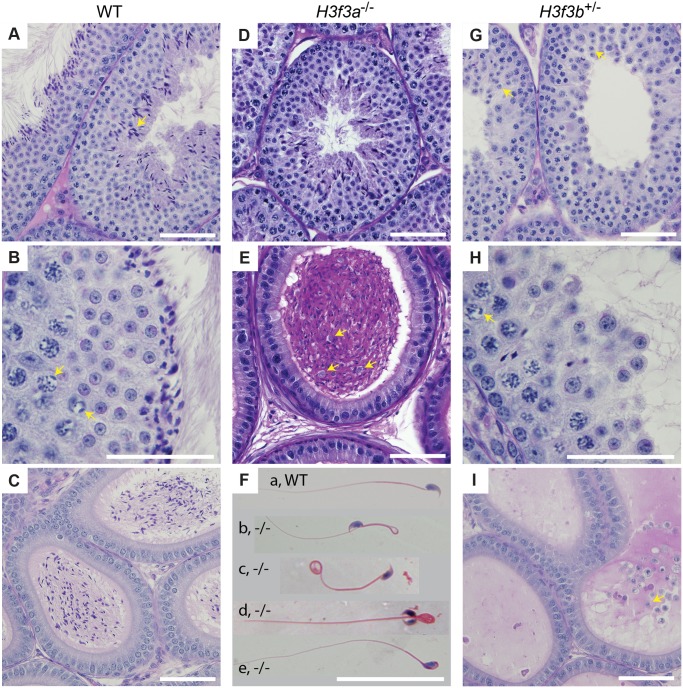
Testis and sperm morphology.WT adult, 6–10 months: (A) seminiferous tubule, condensing spermatid indicated (arrow), (B) seminiferous tubule, XY-body indicated (arrows), (C) cauda epididymis. H3f3a
-/- adult, 6–10 months: (D) seminiferous tubule, (E) cauda epididymis, sloughed germ cells indicated (arrows), (F) spermatozoa, genotype as given; (a) normal, (b) bend back tail, (c) curly tail, (d) double head, (e) abnormal head. H3f3b
-/+ adult, 8 wk: (G) seminiferous tubule, arrested round spermatids (arrows), (H) seminiferous tubule, XY-body indicated (arrow), (I) cauda epididymis, sloughed spermatid indicated (arrow). Paraffin-embedded sections were PAS-stained. Scale bars, 25 μm.